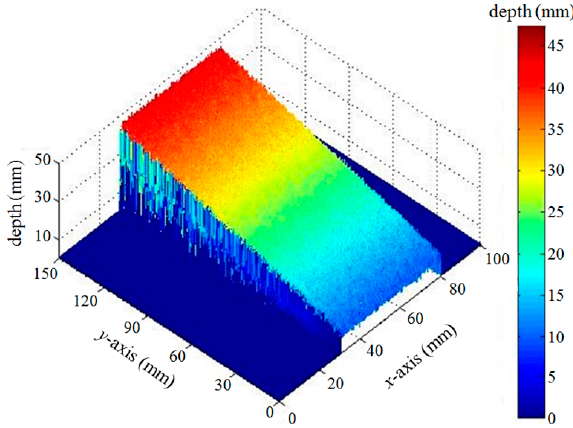
Figure 13. 3D depth profile reconstructed from the slanted object.